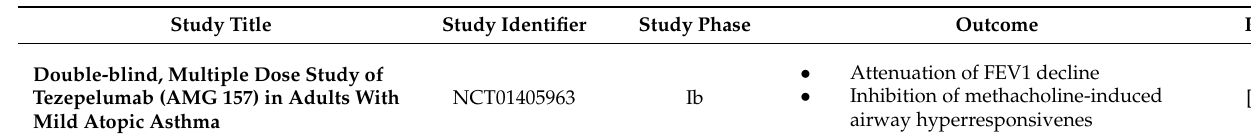
Table 1. Clinical trials of Tezepelumab administration in asthma